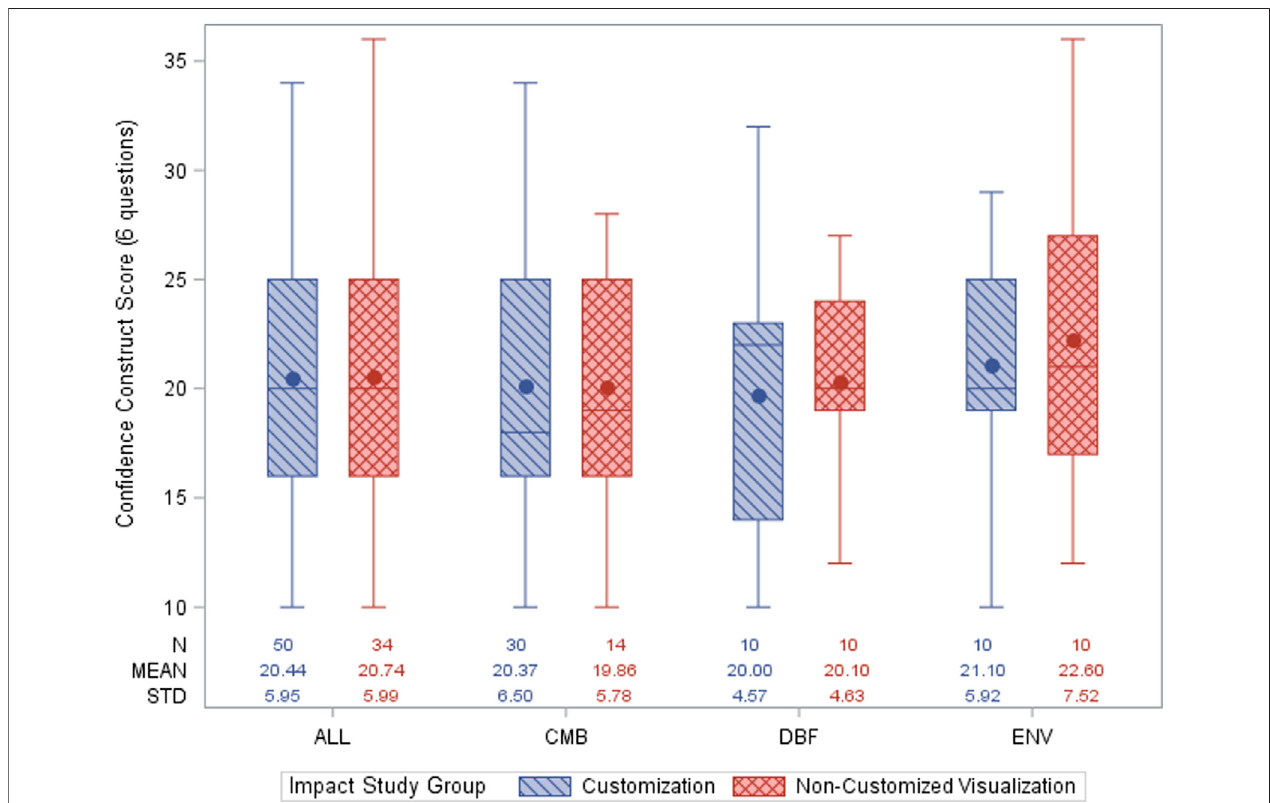
FIGURE 4 | Comparison of the con fi dence construct for study groups: Overall (ALL) and across all three courses (CMB), (DBF),